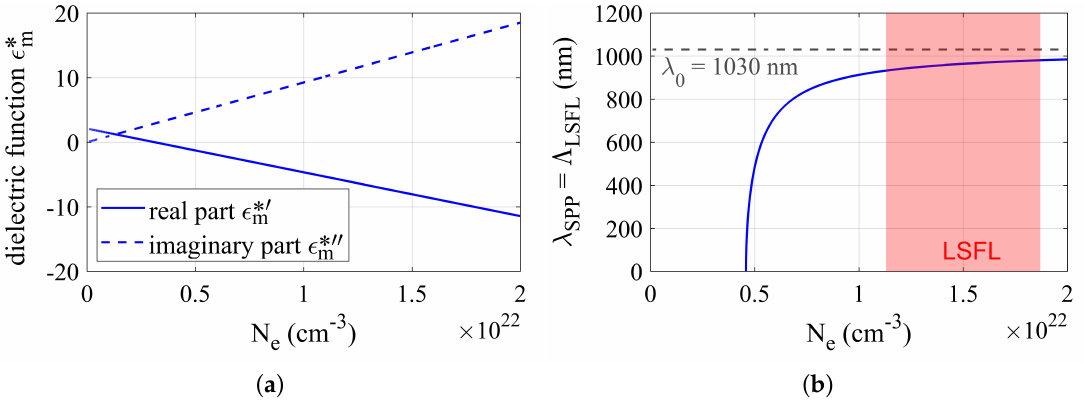
Figure 4. ( a ) Dielectric function ( (cid:101) ∗ m ) of fused silica calculated with a Drude model for femtosecond laser irradiation; ( b ) periodicity of the generated surface plasmon polaritons ( λ SPP ) for increasing carrier density N e , the red area marking the periodicities labeled in Table